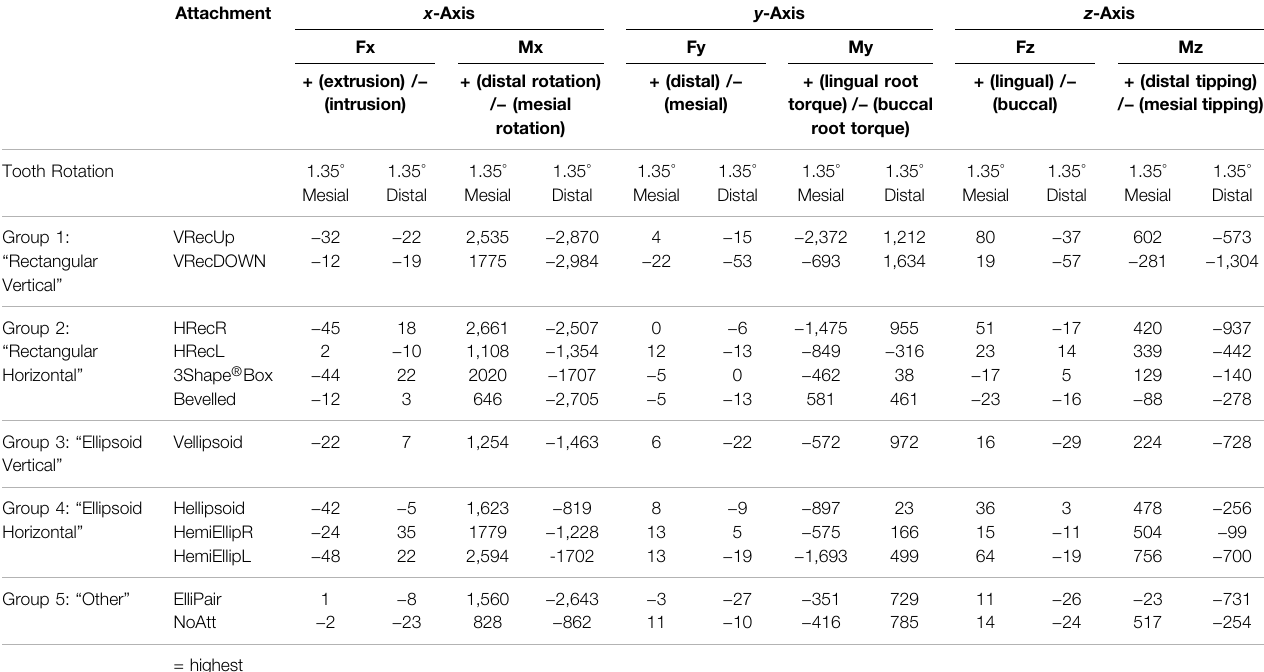
TABLE 2 | Forces (F, in cN) and moments (M, in cNmm) in all three axes at 1.35 mesial and 1.35 distal rotations. When the test tooth is 1.35 mesial rotated, forces and moments are created to disto-rotate the tooth (Mx positive). Attachment